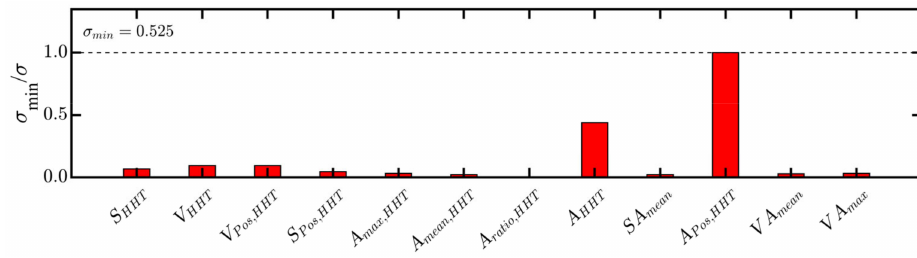
Figure 6. Performance evaluation of proposed HHT-based IMs in predicting the rocking